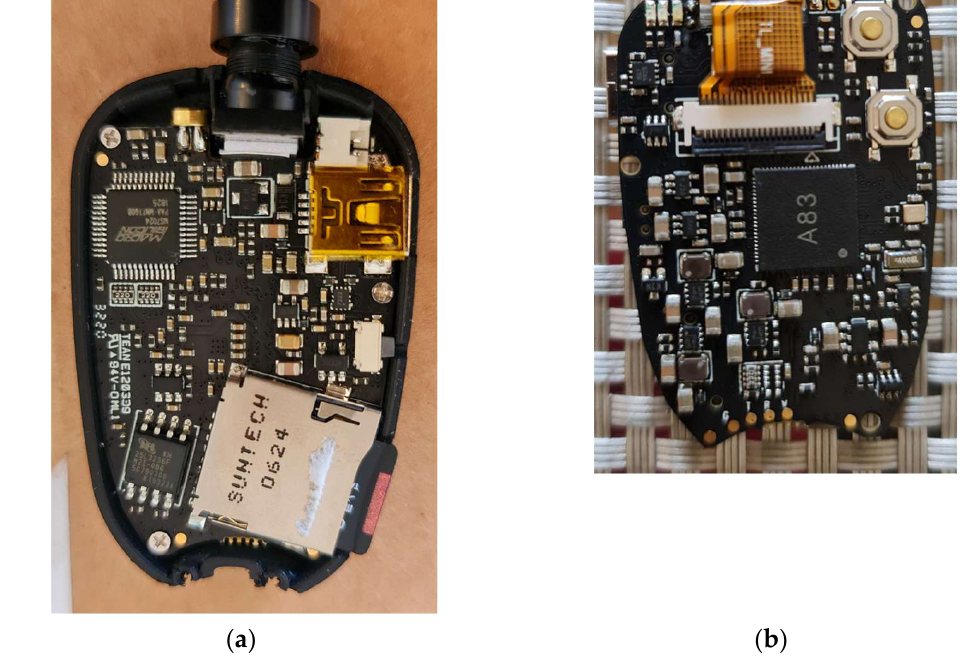
Figure 14. 808#32 camera circuit board front ( a ) and rear ( b ).